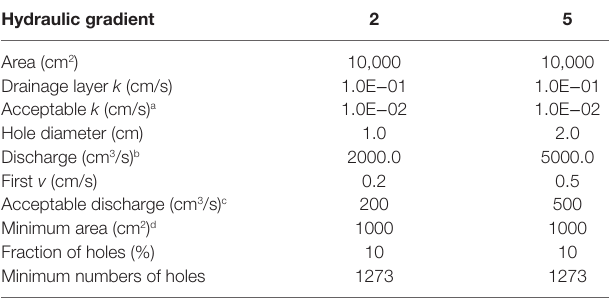
FigUre 7 | slope angle, β , for hDPe(2) plate of geosynthetic separation box: (a) 90° and (B) 45° .